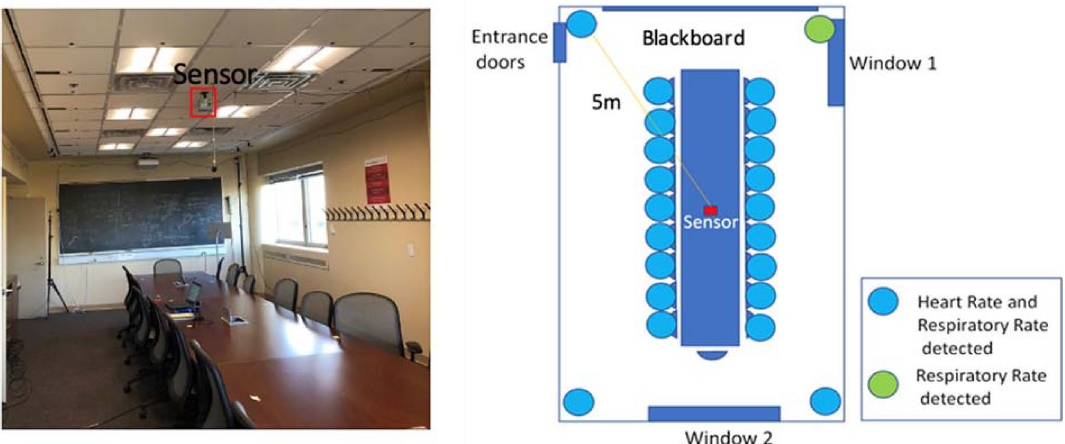
Figure 4. The 3.4 m × 8.5 m LESA Smart Conference Room with the TruePODS™ sensor mounted on the ceiling (left), and locations of successful physiological detection (right). Heart rates were detected at all the seats around the table, and in 3 of the 4 corners. In all locations, respiratory rate was